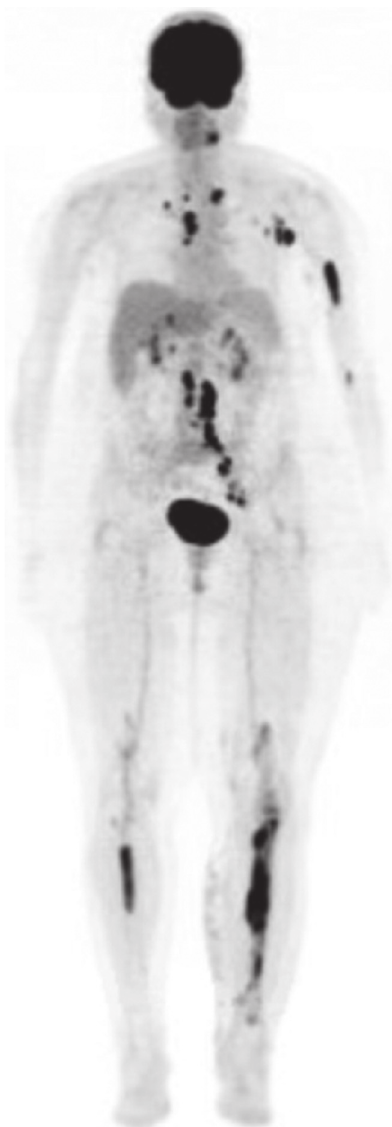
Figure 3: Whole body PET/CT